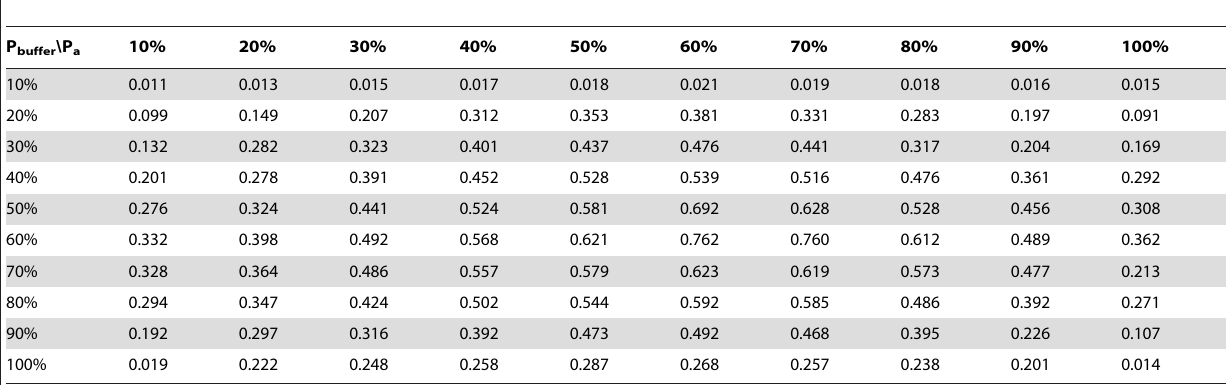
Table 1. The results of KC (Kappa